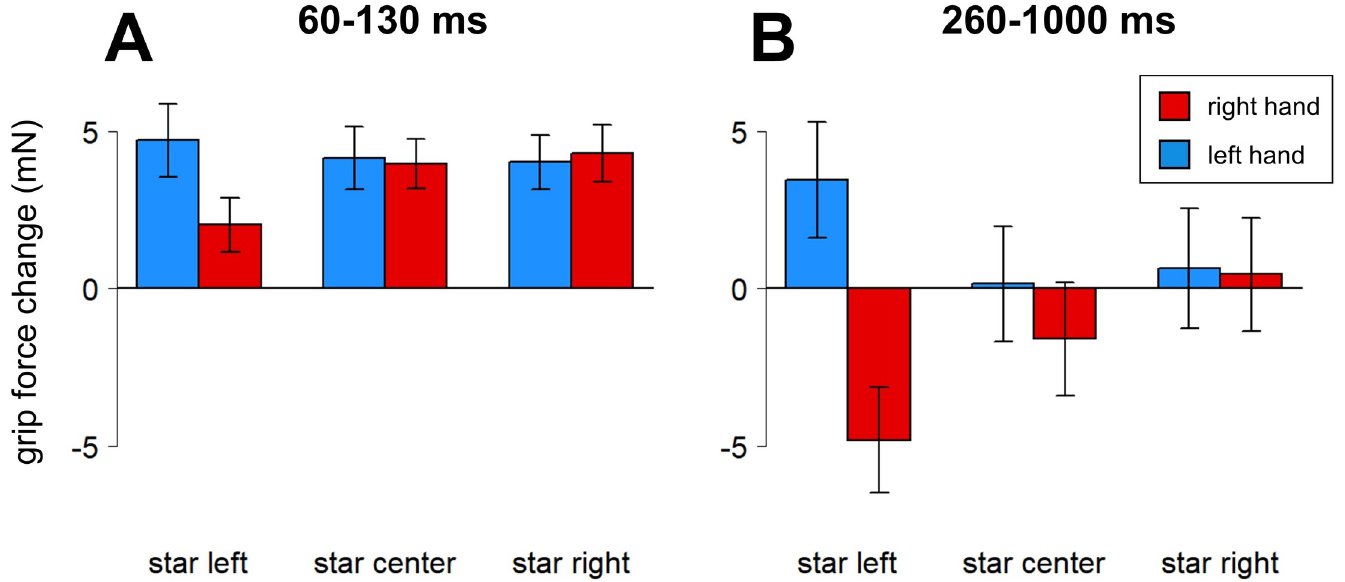
Fig 3. Grip force changes (in milli-Newton) averaged by hand and position, Experiment 1. Panel A. Average forces in time widow 60–130 ms. Panel B. Average forces in time widow 260–1000 ms. Whiskers represent standard errors.